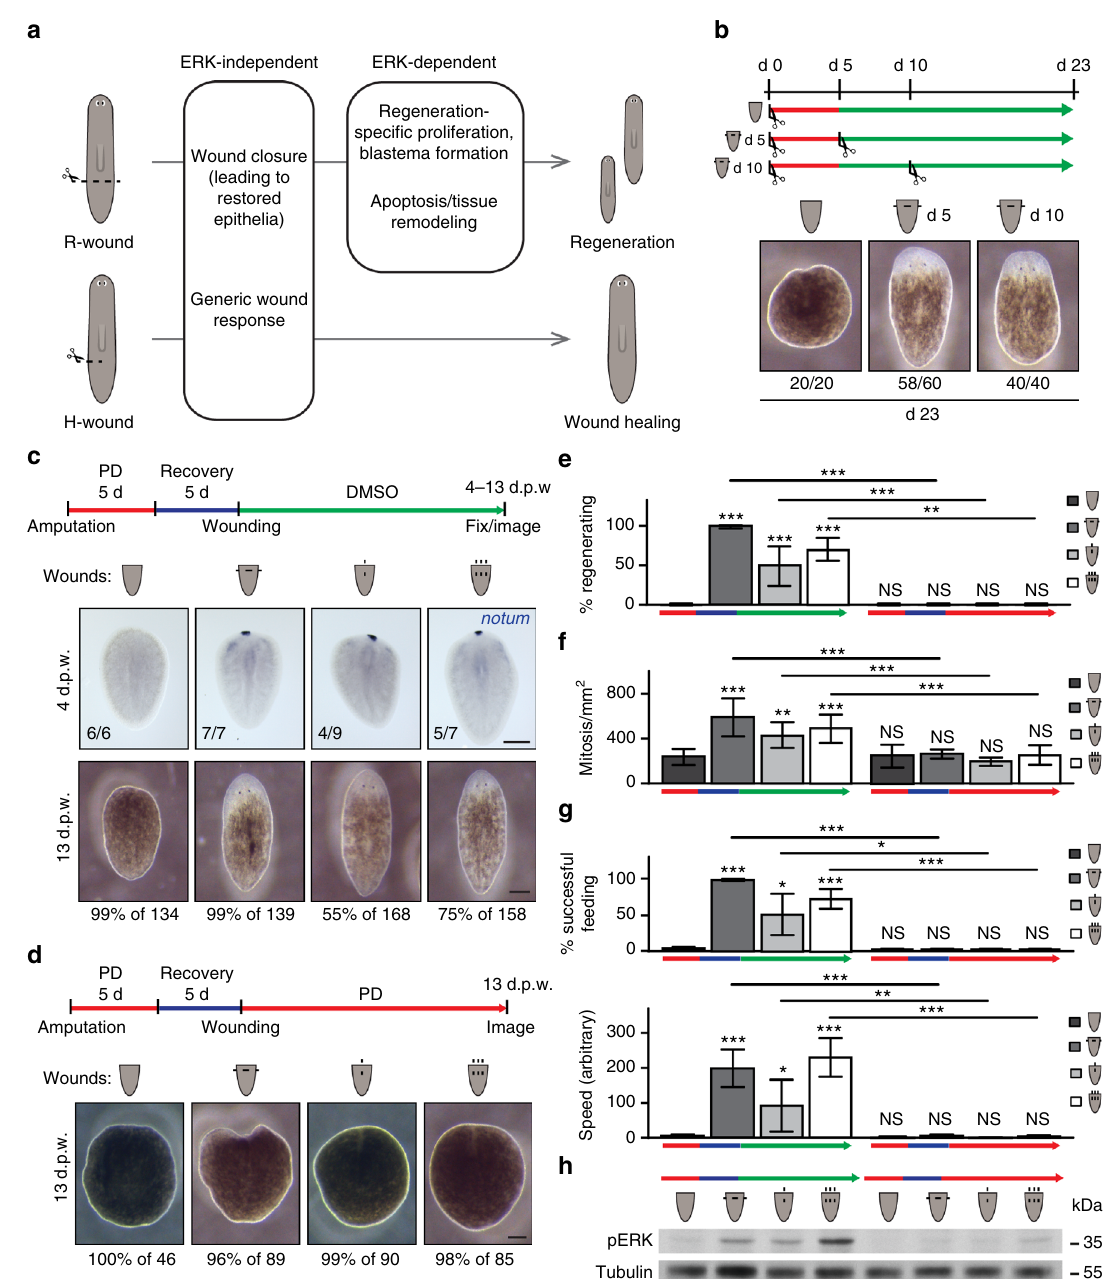
Fig. 3 H-wounds in fl icted on dormant tails induce regeneration in an ERK-dependent manner. a Distinct cellular responses occur in planarians undergoing wound healing (after H-wounds) or regeneration (after R-wounds). b “ Dormant ” tails that were re-amputated, whether immediately or 5 days after drug removal, fully regenerated. c Tail fragments did not regenerate after a 5-day PD treatment and recovery period unless re-injured; as in the case of re- amputations, incisions that cut through the animal along the DV axis but do not involve tissue loss led to the formation of the anterior regeneration pole (marked by notum ; sample numbers indicated in each image) and full regeneration of heads and medial structures (see Supplementary Fig. 6 for representative images of immediate wounds). During the recovery period (blue in scheme), animals were kept in DMSO-containing water. d Induction of regeneration through re-injury was inhibited by PD treatment. e Animals that had formed blastemas were considered to be “ regenerating ” if they later also regenerated eyes. f – g Corresponding proliferative responses at 4 d.p.a. ( f ) and functional recovery ( g ) were observed. Bars in graphs represent mean ± s.d.; two-sided t test (compared with uninjured PD-removed animals ( fi rst bar, dark gray), unless indicated otherwise), * p < 0.05, ** p < 0.01, *** p < 0.001, NS, not signi fi cant. h Increased pERK levels were observed at 3 h post-wounding in conditions that induced regeneration. d.p.w. days post-wounding, scale